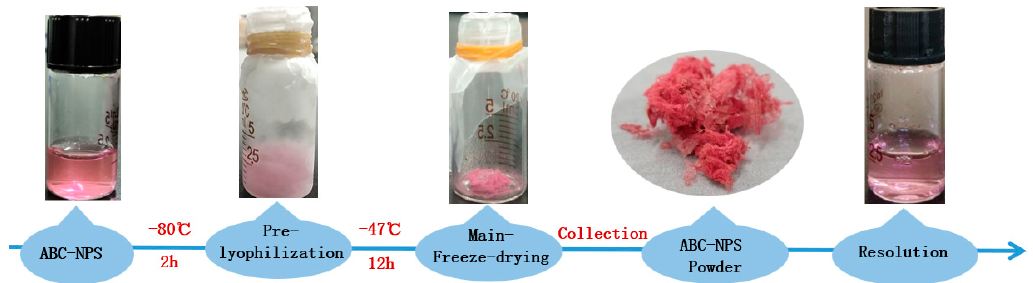
Figure 1. Freeze-drying flow chart.